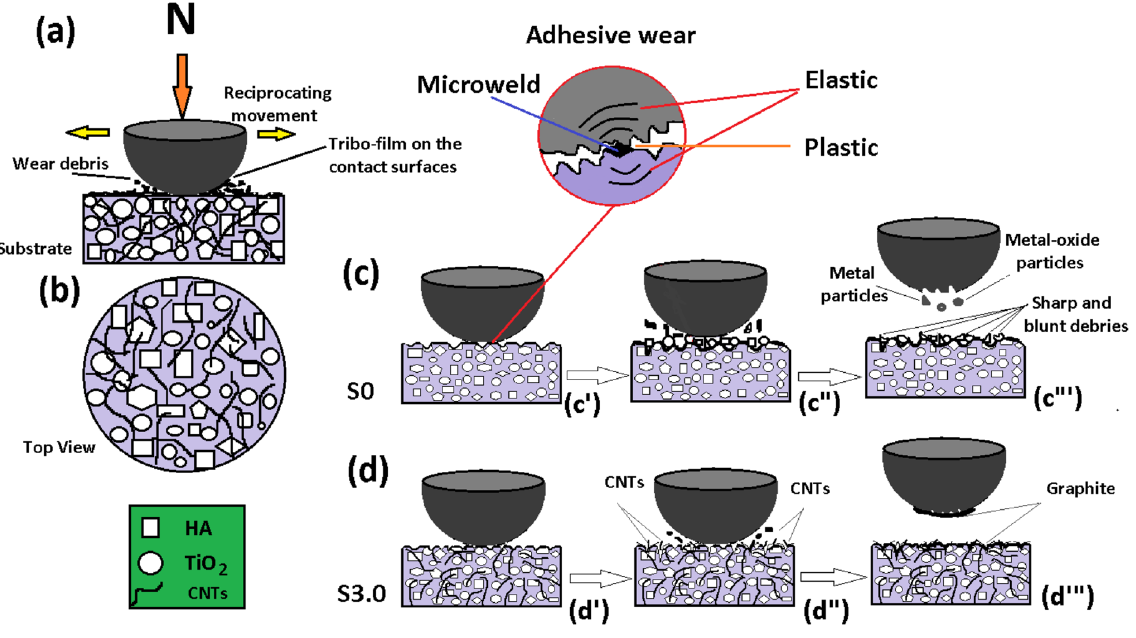
Figure 12. Schematic of ( a ) reciprocating wear, ( b ) top view of HA/TiO 2 /CNT nanocomposite, ( c ) reciprocating wear of S0 and ( d ) reciprocating wear of